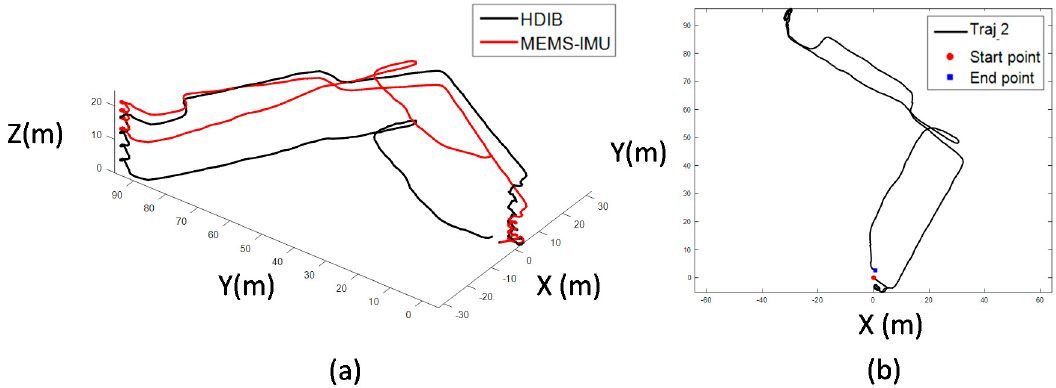
Figure 29. Positioning result of Traj_2; ( a ) is the 3D view of the positioning result; ( b ) is the top view of the positioning result. TTDE of Traj_2 is 0.76% and the height error is 0.27 m. Traj_3 is a walking/running mix trajectory along a rectangle of 5 loops. The positioning result is